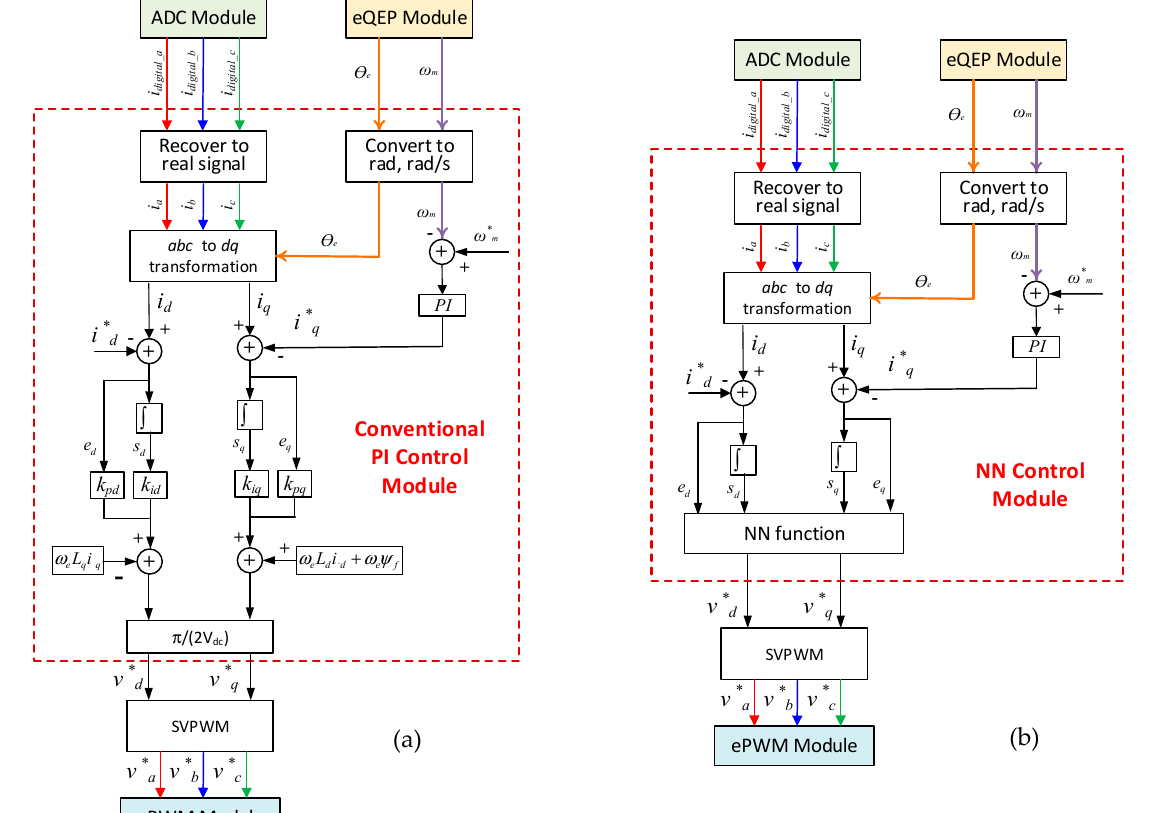
Figure 10. Conventional standard proportional-integral (PI) and NN control modules. ( a ) Conventional standard PI control module. ( b ) NN control module. Each of the PI and NN control modules is only executed each time a sampling-controlled interrupt is generate.